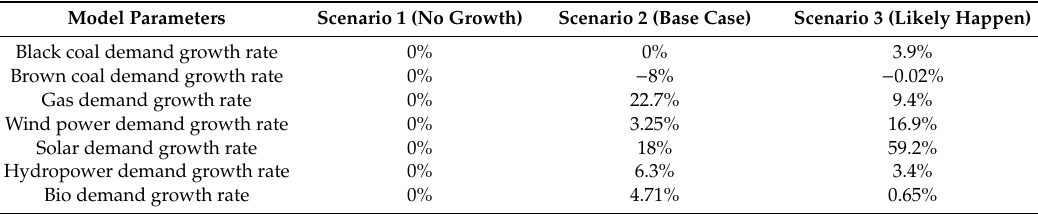
Table 1. Energy sector development